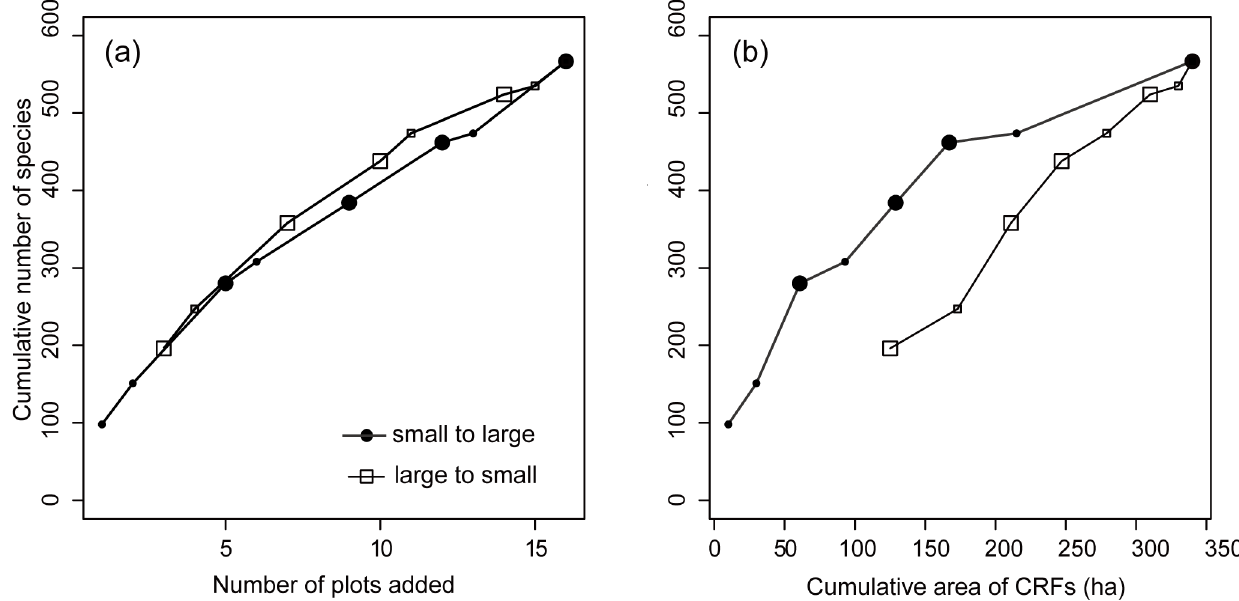
Fig 3. Species-area curve. Cumulative number of tree species sampledin 0.25-ha plots against (a) cumulativeplot number and (b) CRF area added. The plots or CRFs were added from smallest to largest (black circle) or largest to smallest (blank square), respectively.The bigger symbols indicate that a CRF has three plots, i.e., three plots were addedat once.